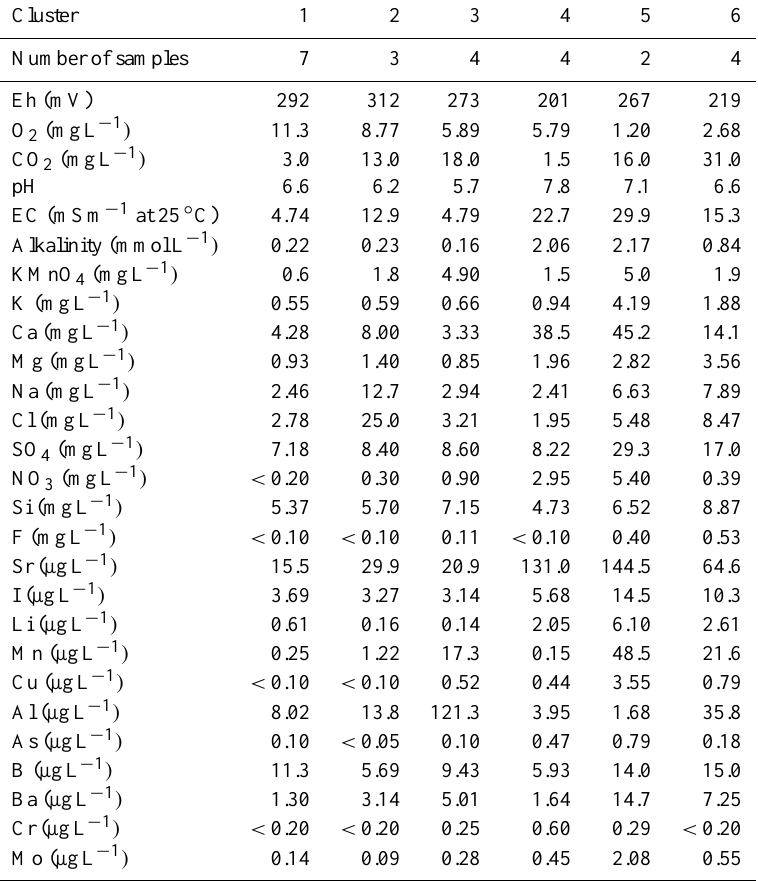
Table 5. Median values of variables in each cluster from groundwater samples ( n = 24) taken during spring (April) and summer (August)